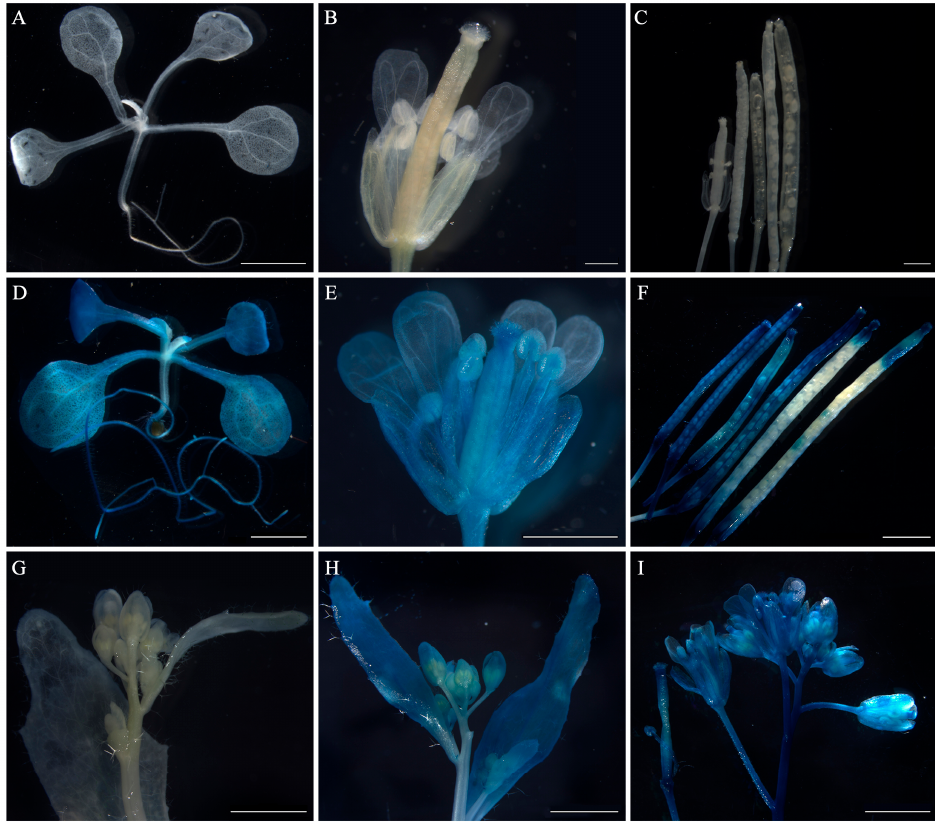
Figure 6. Histochemical GUS staining of pFaesAP1::GUS transgenic Arabidopsis. ( A ) Wild-type Arabidopsis seedling; ( B ) wild-type Arabidopsis flower; ( C ) wild-type Arabidopsis fruits at various development stages; ( D ) seedling of pFaesAP1::GUS transgenic Arabidopsis; ( E ) flower of pFaesAP1::GUS transgenic Arabidopsis; ( F ) pFaesAP1::GUS transgenic Arabidopsis fruits at different